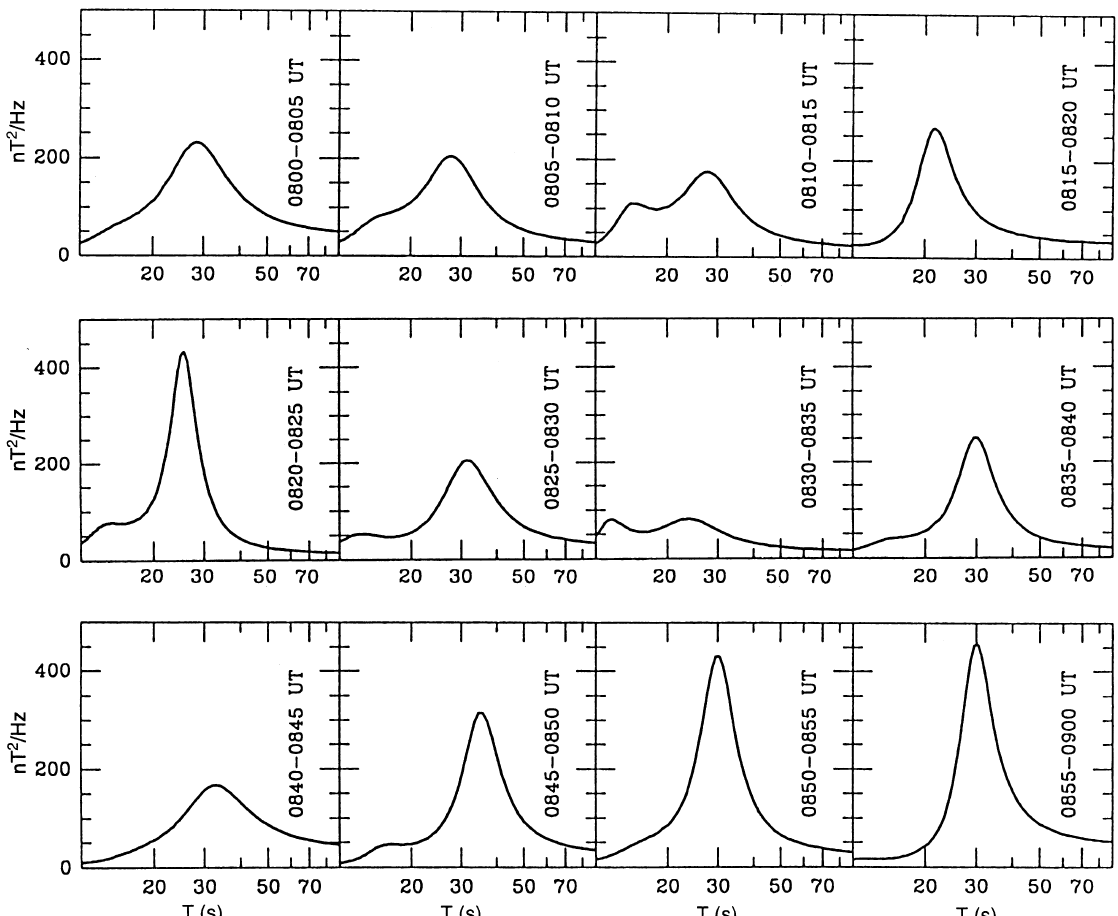
Fig. 8. Power spectra for the y -component of the IMF evaluated every 5 min, with the maximum entropy method at the order 15